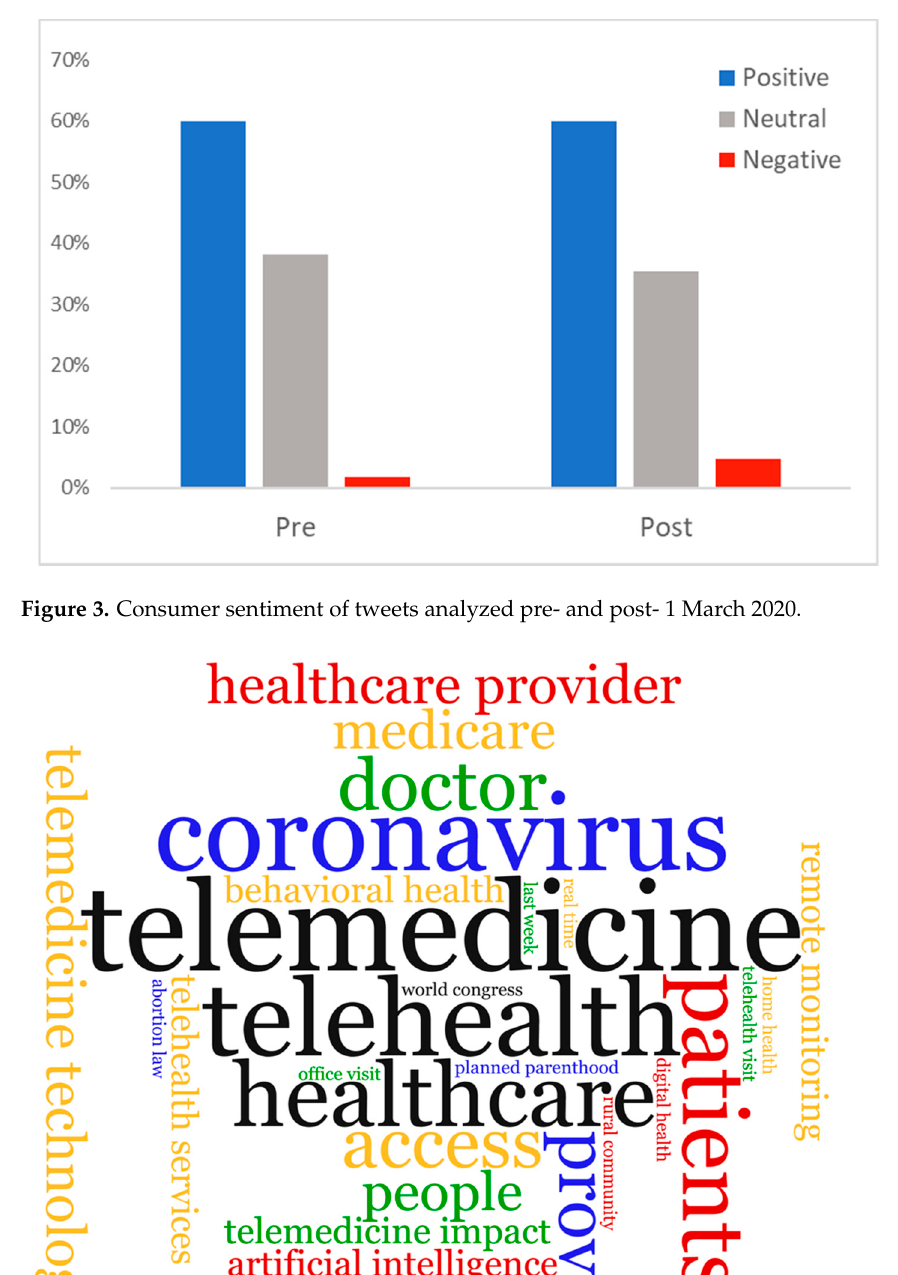
Figure 4. Word cloud visualization of most used telehealth-related bigrams and unigrams found in tweets between November 2019 and April 2020.